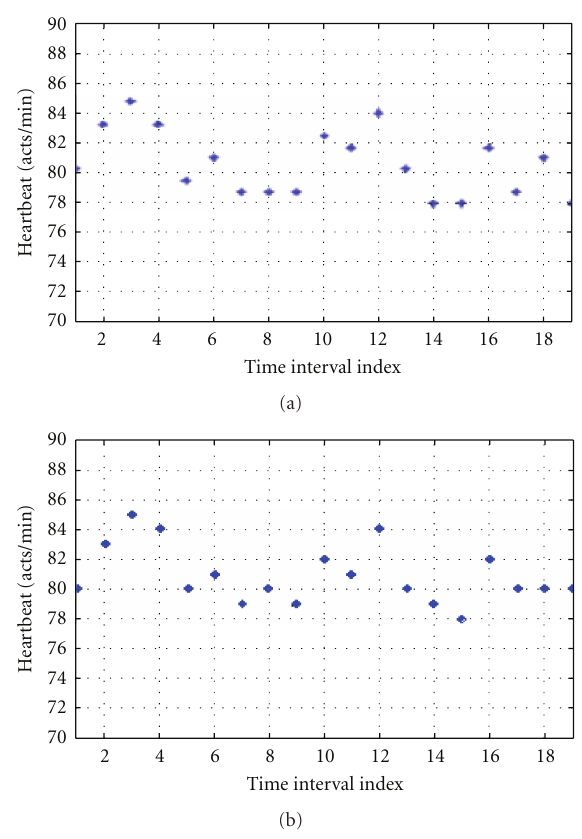
Figure 6: Comparison between the data-processing approaches for the heartbeat. (a) first dataprocessing approach; (b) second data- processing